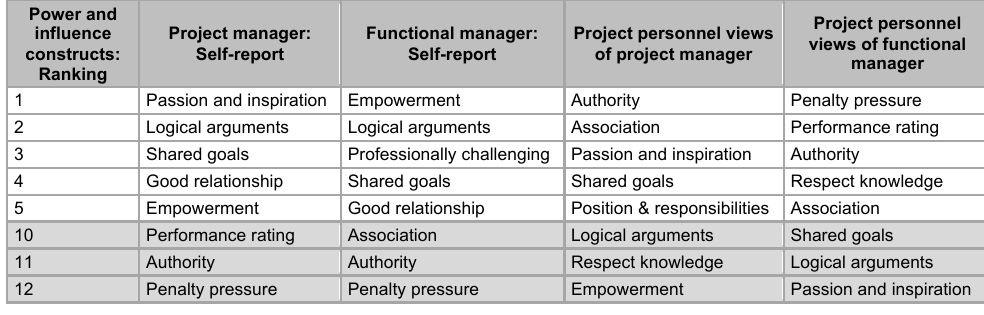
Ranked constructs for each stakeholder